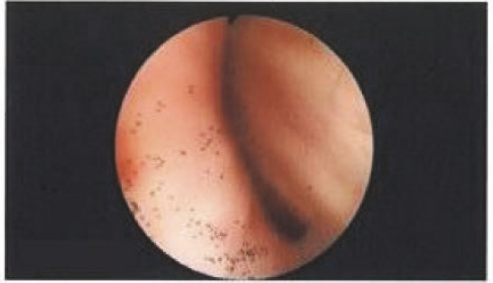
Figure 2: Bronchoscopy after induction of anesthesia revealed tracheal stenosis that gradually became more severe from under the